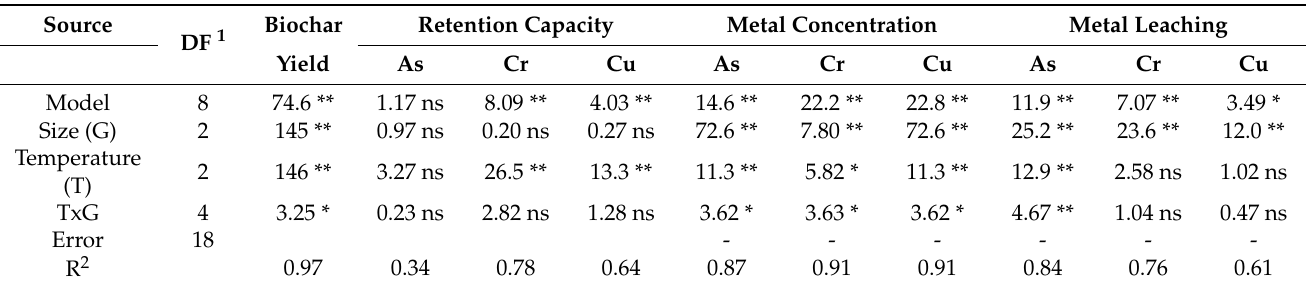
Table 4. Analysis of variance (F values) of the effects of particle size and pyrolysis temperature on metal concentration and leaching.